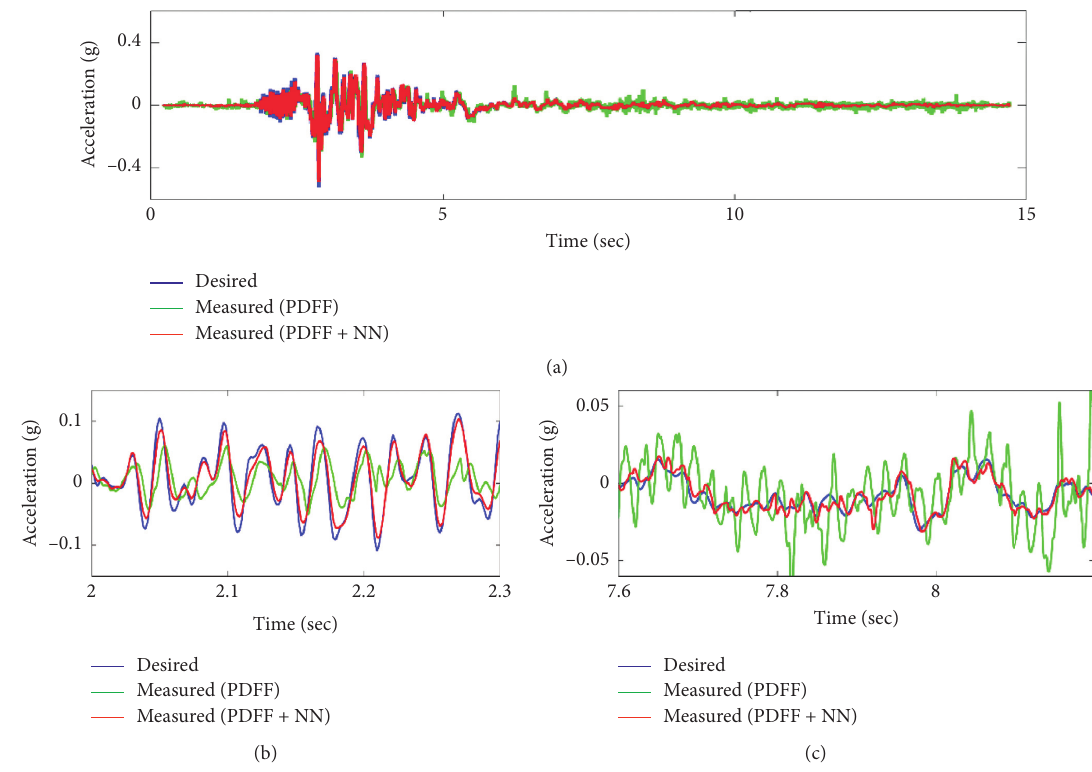
Figure 12: Time history comparison between the measured and the desired acceleration for the El Centro earthquake record (loaded table).